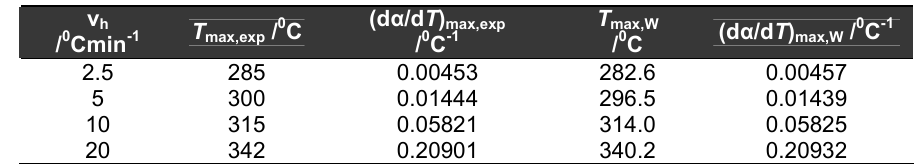
Table 3 – The comparison of the experimental (exp) and the calculated (W) (Eq. (15) and Fig. 6) values of T max and (d α /dT) max for the reduction process of NiO under hydrogen atmosphere at different heating